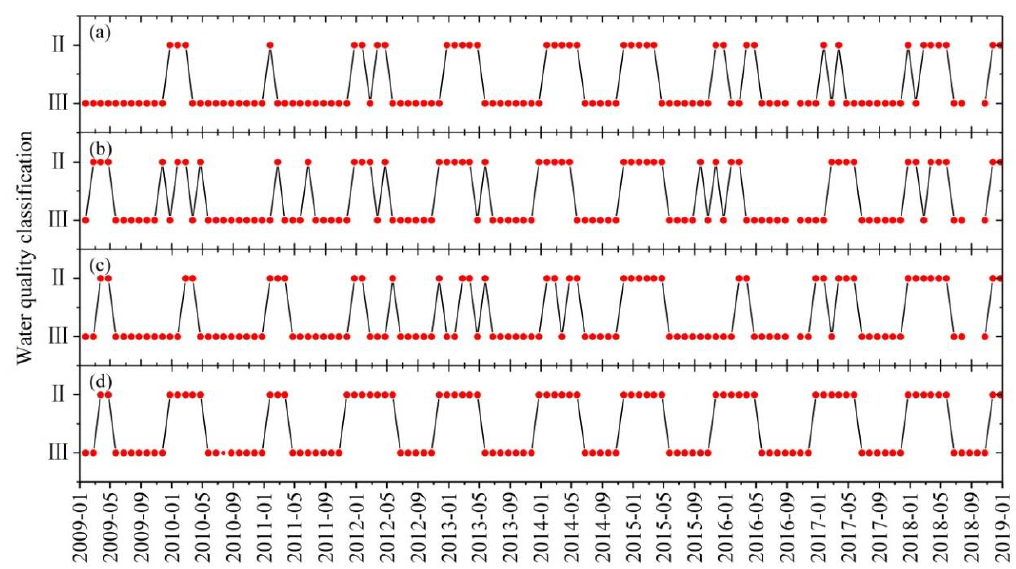
Figure 8. Monthly variation of water quality classification at the northern ( a ), central ( b ), southern ( c ) and whole of ( d ) Erhai Lake.